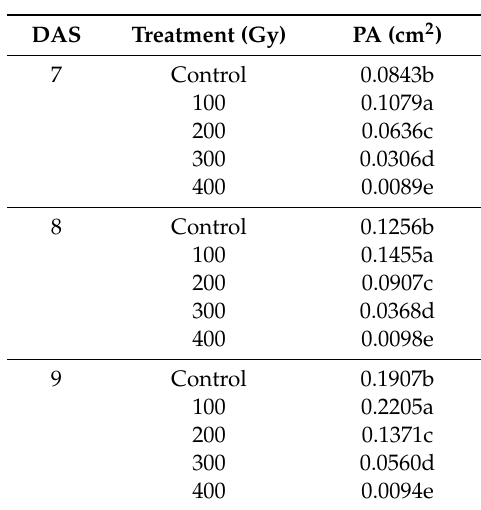
Table 2. Comparing the projected areas of four irradiated Arabidopsis populations on consecutive days after sowing (DAS). Values in the same column followed by a di ff erent letter are significantly di ff erent ( p < 0.05). PA: projected